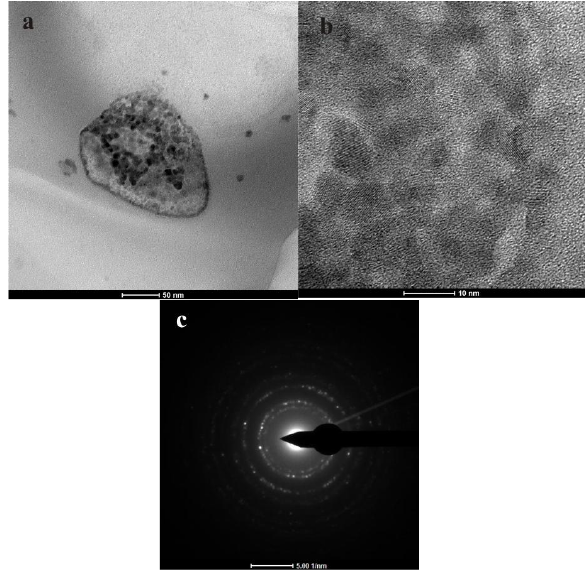
Figure 7. Panel (a) shows the TEM image, (b) HRTEM image, and (c) SAED pattern of an O-, S-, K-, and Pb-containing particle ag- gregation obtained from an ascending gas flow above the soil over the Dongshengmiao deposit.